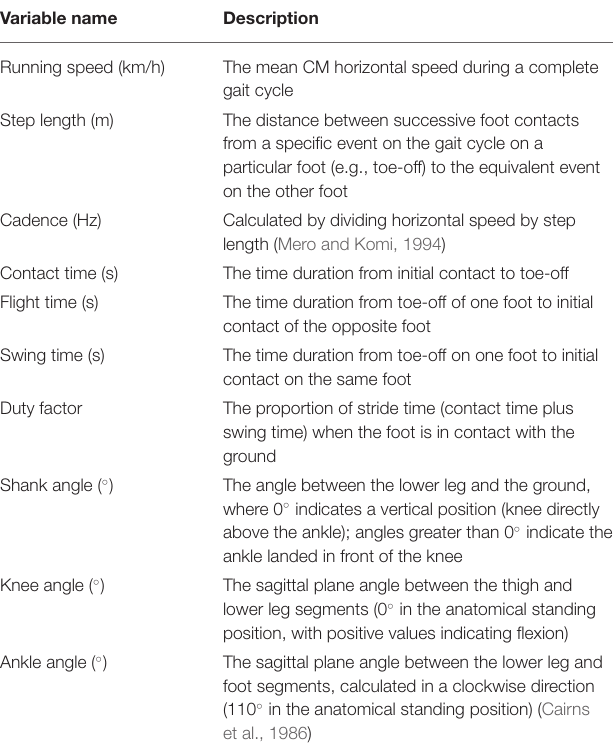
TABLE 1 | Variables analyzed in the study and their